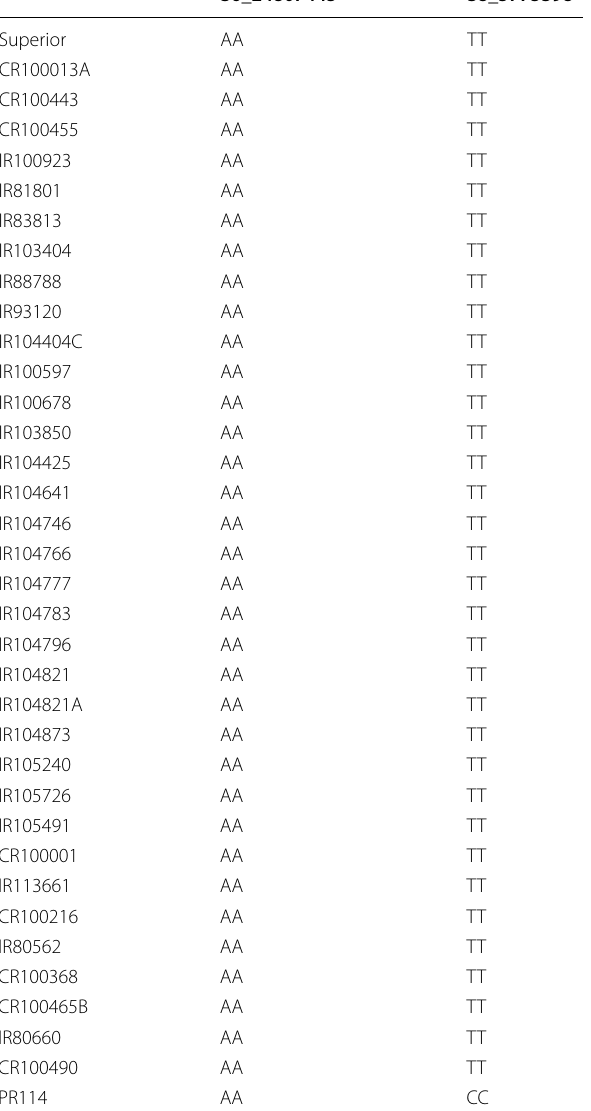
Table 10 The list of O. rufipogon accessions possessing Table 11 The list of O. rufipogon accessions possessing combination of superior alleles at significant SNP positions combination of superior alleles at significant SNP positions associated with PB where SNPs marked with * represent alleles associated with GL where SNPs marked with * represent alleles absent in indica cultivars absent in indica cultivars S4_30721851